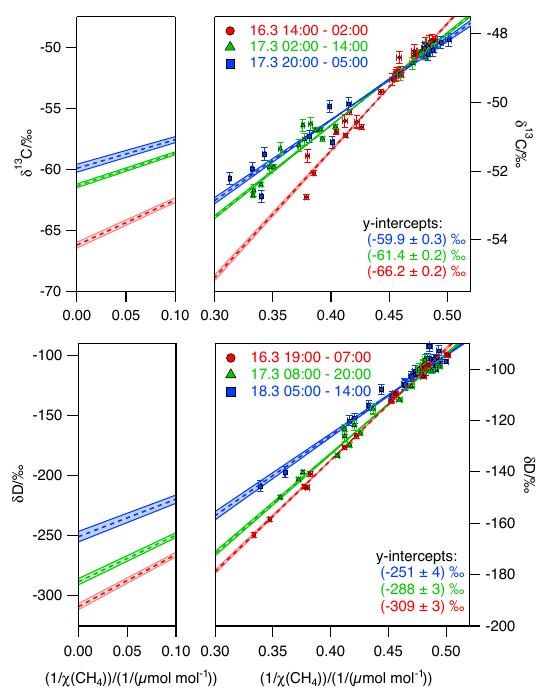
Figure 8. Keeling plots for the period between 16 and 18 March, il- lustrating a rapid change in δ values over the course of hours, which is most probably related to a change from mainly ruminant-derived CH 4 to a significant contribution of fossil and/or waste CH 4 . The dashed lines indicate the regression line; the shaded areas show the uncertainty (1 standard deviation) of the regression line. Left pan- els show the region near the y axis intercept. Times indicated are central European time